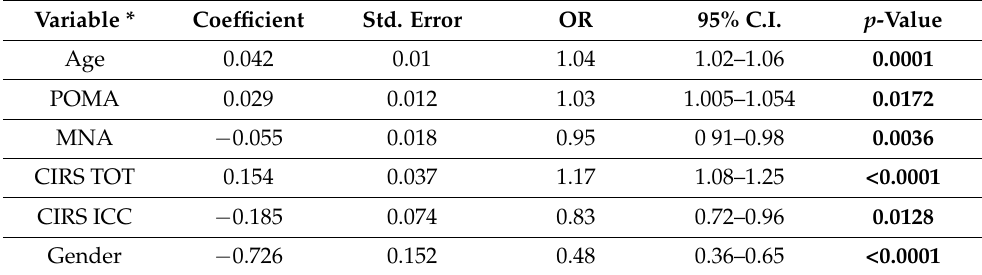
Table 9. Logistic regression stepwise Hb < 13